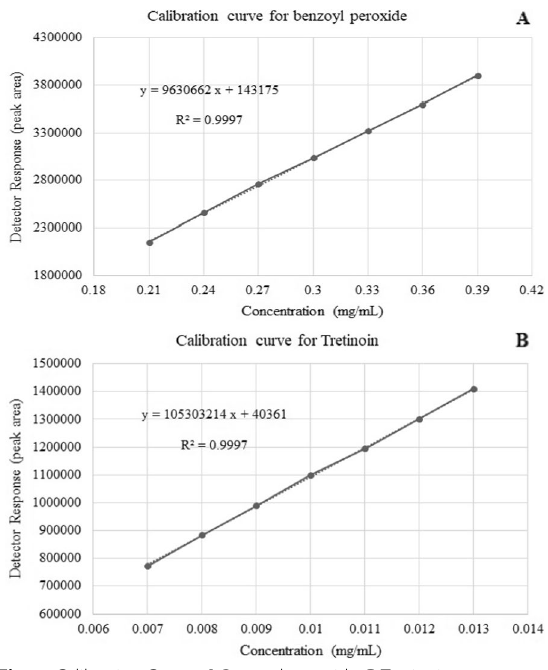
Fig. 4 Calibration Curves A Benzoyl peroxide, B Tretinoin